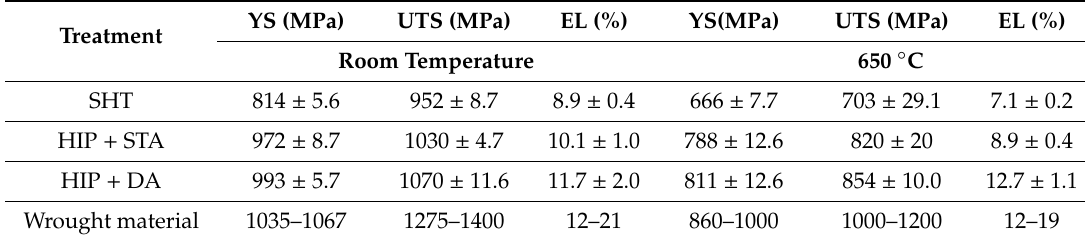
Figure 7. The tensile properties of the SHT, HIP + STA, and HIP + DA Inconel 718 superalloys at room temperature and at 650 °C. Table 3. The mean values of yield strength (YS), ultimate tensile strength (UTS), and elongation (EL) of the SHT, HIP + STA, and HIP + DA Inconel 718 superalloys at room temperature and at 650 °C.